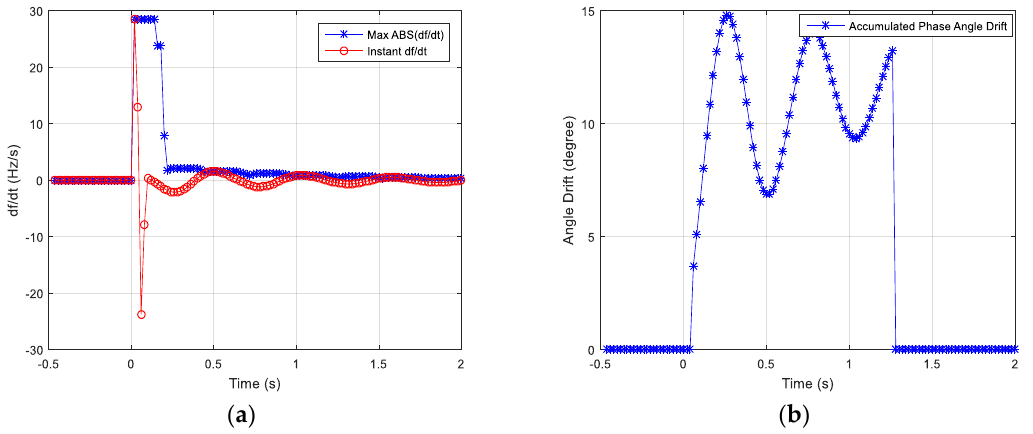
Figure 11. ( a ) Maximum and instantaneous ROCOF values; ( b ) accumulated phase angle drift under frequency fluctuation after large load switching off.